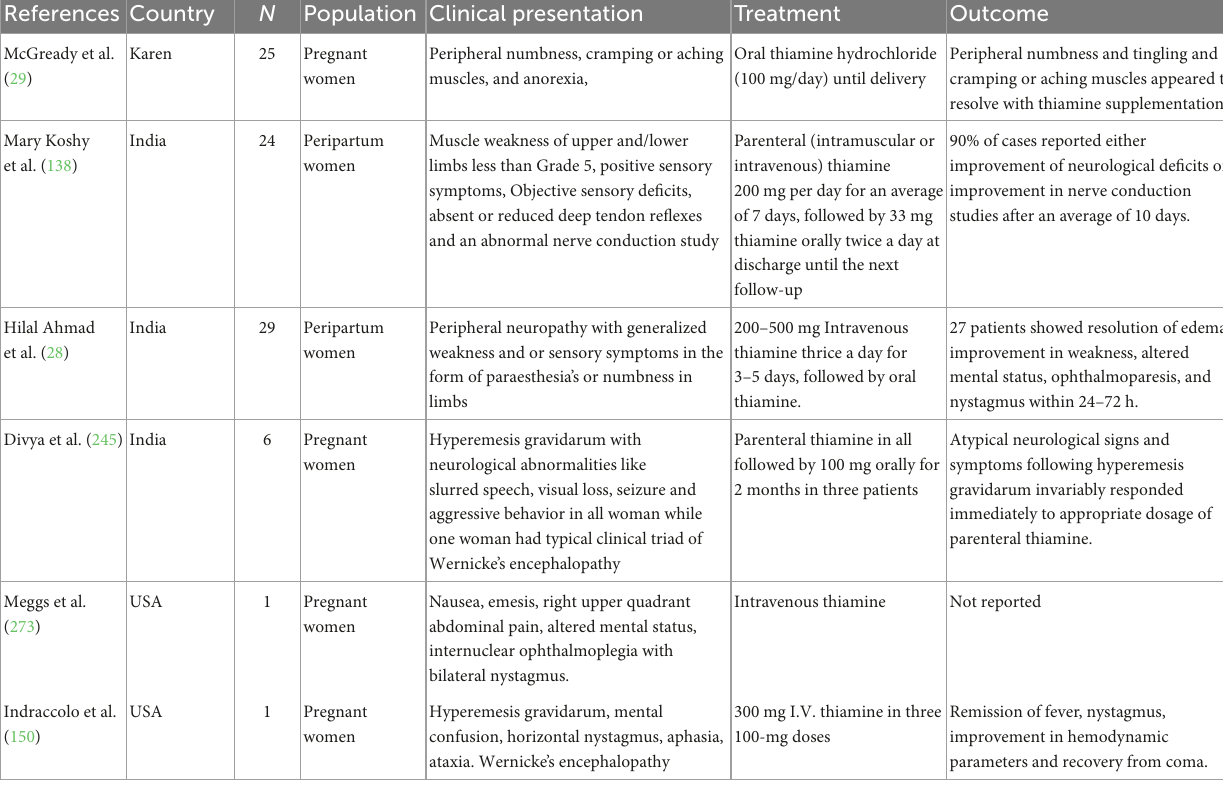
TABLE 2 The studies reporting thiamine deficiency among